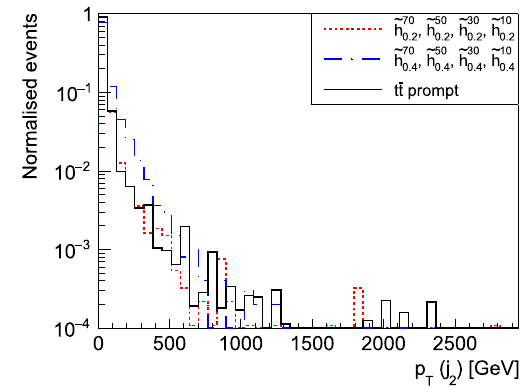
Fig. 35 Transverse momentum p T of the leading lepton in the ˜ h 2 -like case